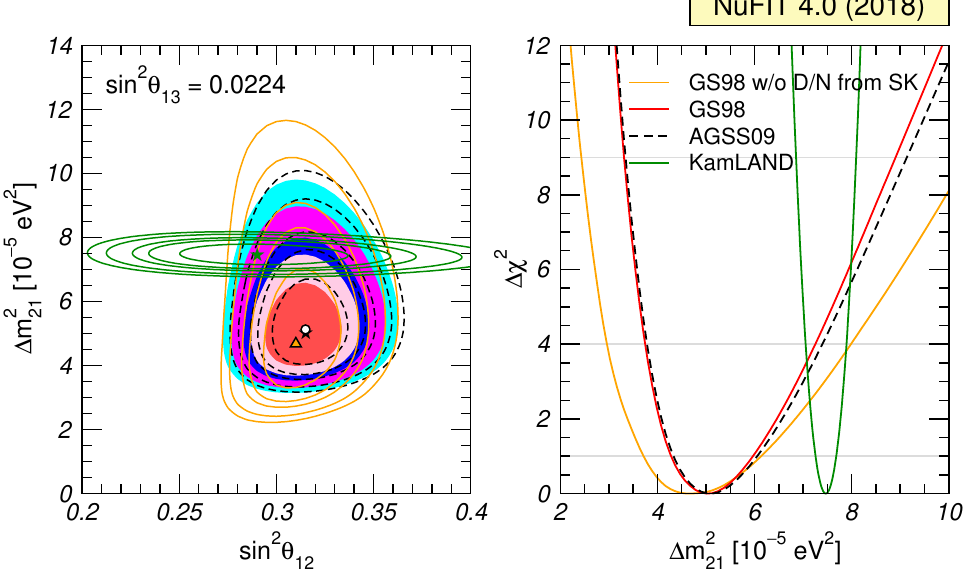
Figure 4 . Left: allowed parameter regions (at 1 (cid:27) , 90%, 2 (cid:27) , 99%, and 3 (cid:27) CL for 2 dof) from the combined analysis of solar data for GS98 model (full regions with best (cid:12)t marked by black star) and AGSS09 model (dashed void contours with best (cid:12)t marked by a white dot), and for the analysis of KamLAND data (solid green contours with best (cid:12)t marked by a green star) for (cid:12)xed sin 2 (cid:18) 13 = 0 : 0224 ( (cid:18) 13 = 8 : 6). We also show as orange contours the results of a global analysis for the GS98 model but without including the day-night information from SK. Right: (cid:1) (cid:31) 2 dependence on (cid:1) m 2 for the same four analyses after marginalizing over (cid:18) 12 21